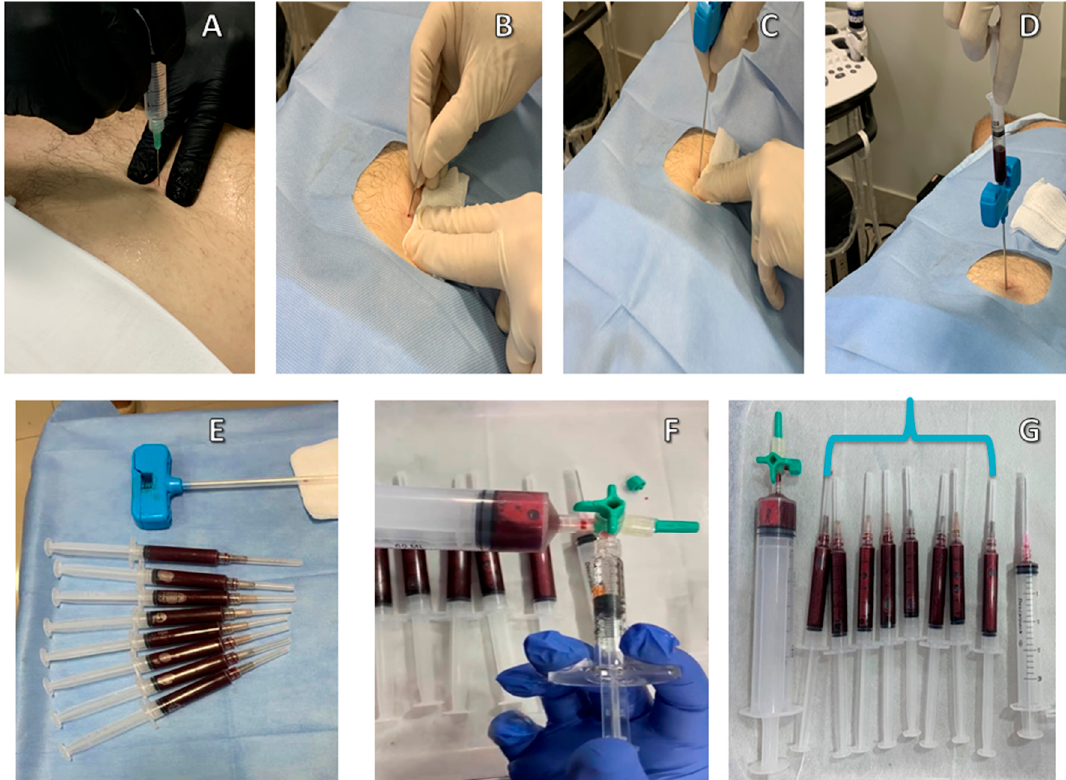
Figure 2. Preparation of fresh autologous bone marrow aspirate matrix. ( A ) Application of local anesthesia; ( B ) target point incision; ( C ) posterior iliac crest puncture; ( D ) aspiration of fresh bone marrow; ( E ) anticoagulant-free syringes filled with bone marrow aspirate; ( F ) bone marrow aspirate mixed with hyaluronic acid; ( G ) Bone Marrow Aspirate Matrix inside the 3 mL syringes (indicated by the blue bracket).